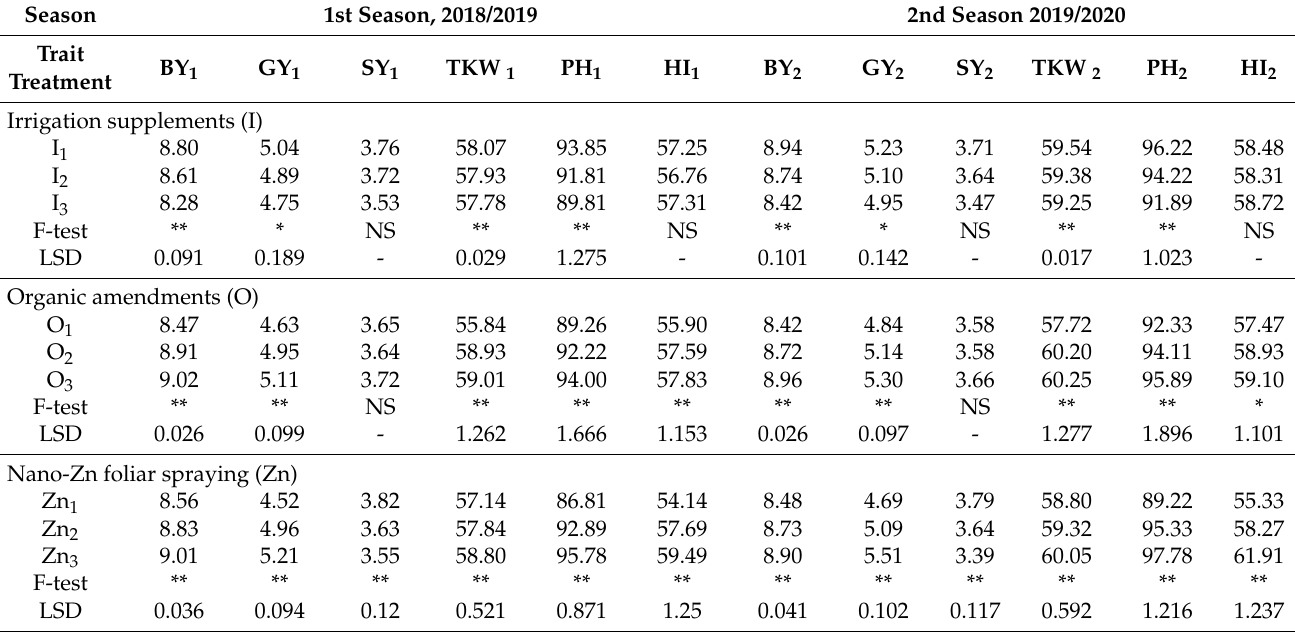
Table 4. Effect of different organic amendments and nano-Zn foliar spraying concentrations under irrigation supplements on agronomical traits in two growing seasons 2018/19 and 2019/20.